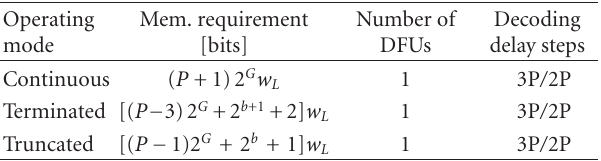
Table 1: Complexity and decoding delay of log-MAP